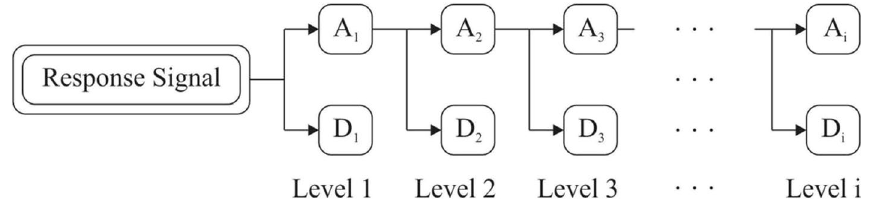
Fig. 1 Schematic view decomposition process of a signal using